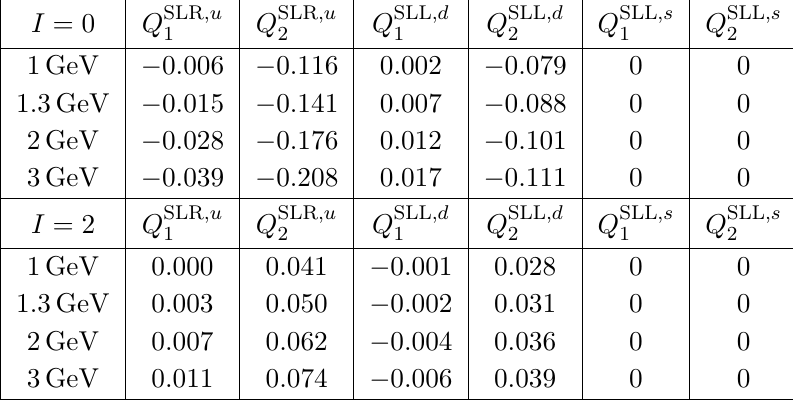
Table 5 . Matrix elements h X i i 0 ; 2 of BSM operators in the SD basis allowed by SU(3) but not by SMEFT contributing to the isospin amplitudes A 0 ; 2 in units of GeV 3 for four values of (cid:22)